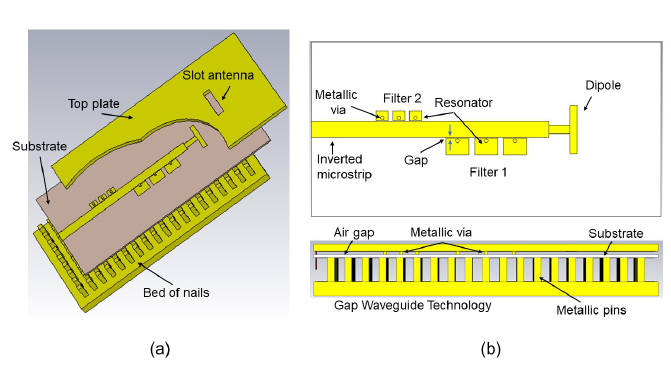
Figure 1. Filtering antenna topology in IM-GWG. ( a ) 3D view of the multilayer configuration. ( b ) Top view of the printed circuit layer and side view of the